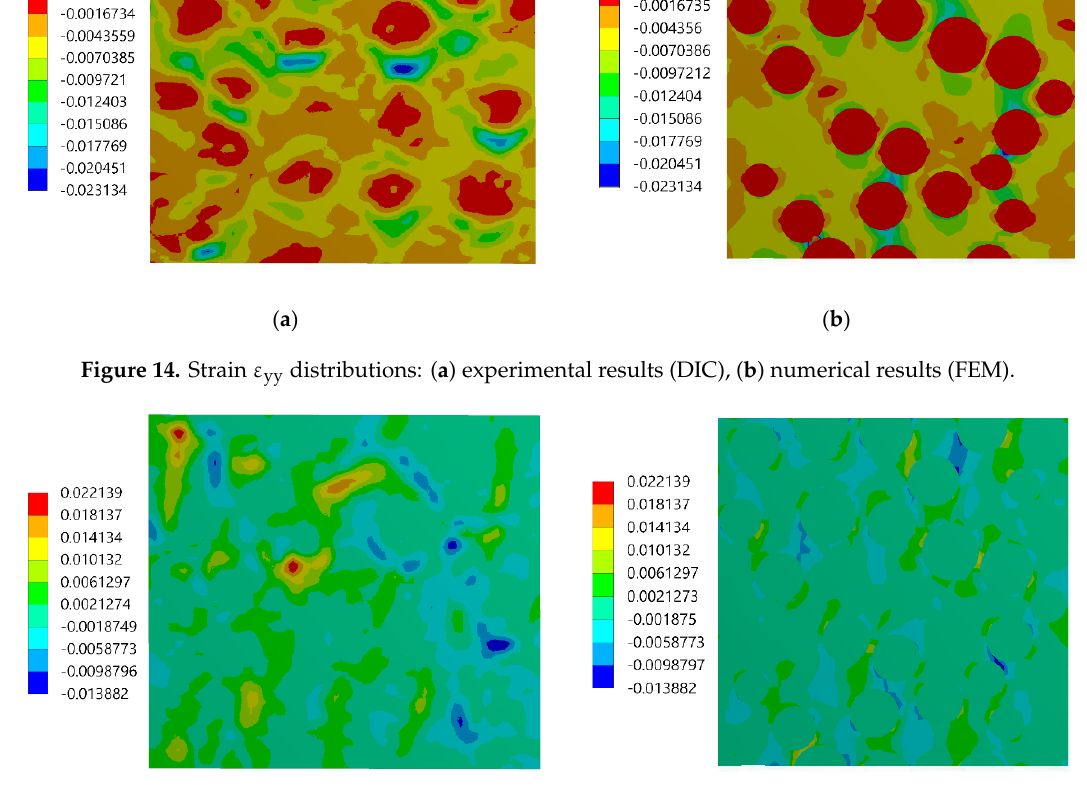
Figure 15. Strain ε xy distributions: ( a ) experimental results (DIC), ( b ) numerical results (FEM).